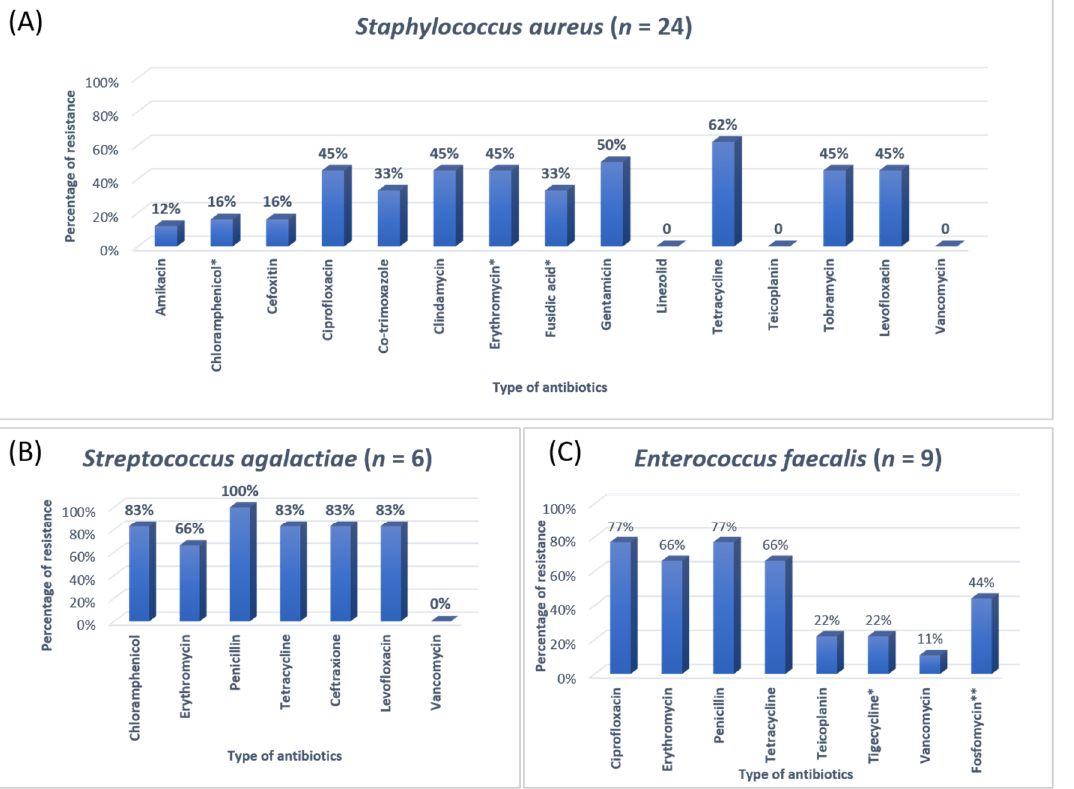
Figure 1. The antibiotic resistance patterns in ( A ) Staphylococcus aureus , ( B ) Streptococcus agalactiae , ( C ) Enterococcus faecalis . * Not reported in urinary isolates. ** Reported in urinary isolates